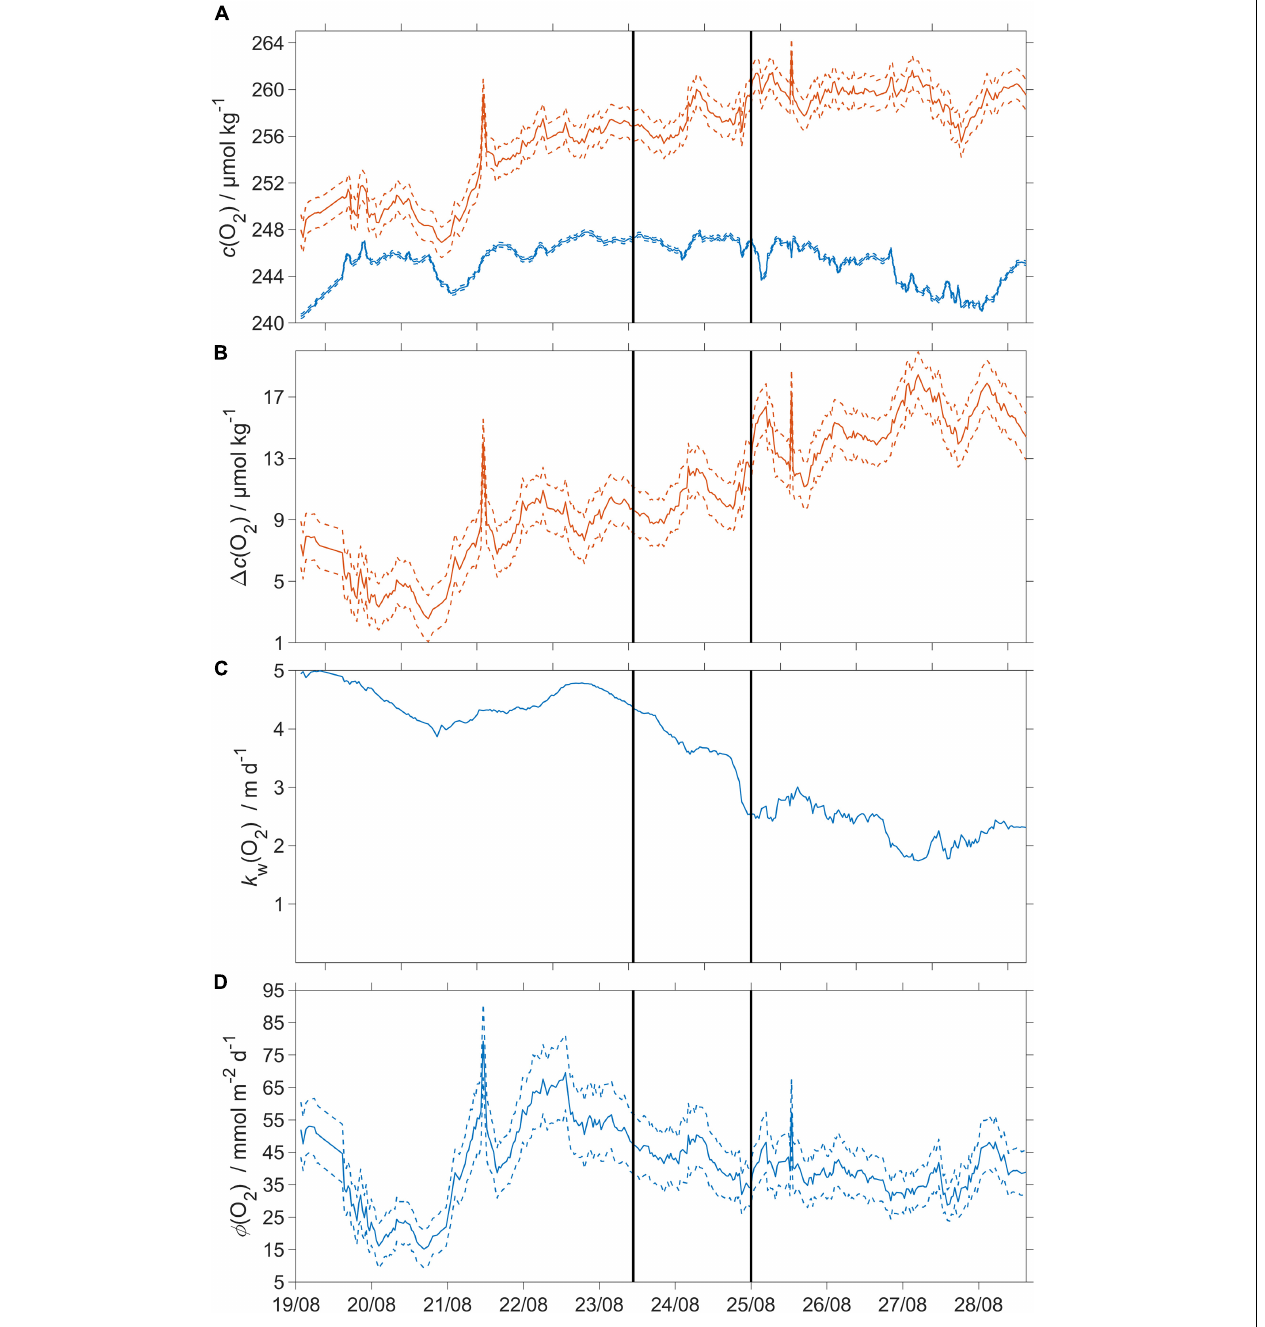
FIGURE 8 | Oxygen air-sea flux and related quantities. Dashed lines represent uncertainties and the black vertical lines divide the three regimes. (A) Blue: c sat (O 2 ), red: c (O 2 ); (B) (cid:49) c (O 2 ) = c (O 2 ) – c sat (O 2 ), (C) k w (O 2 ) weighted over the preceding 7 days (Reuer et al., 2007); (D) oxygen air-sea flux Φ (O 2 ). The flux from sea to air is positive while that from air to sea is negative.